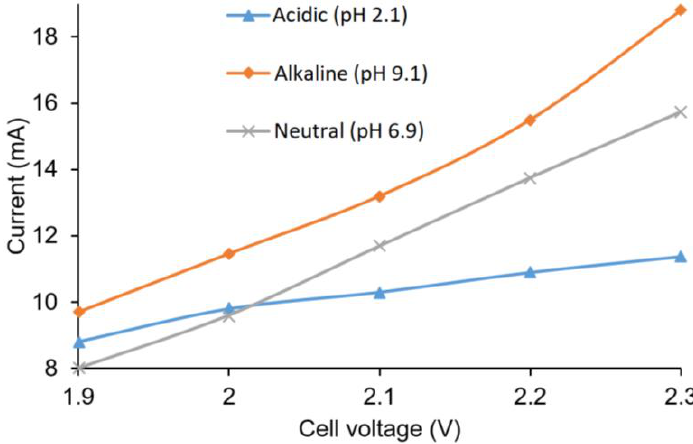
Figure 5. Cell voltage and current output in the buffer solutions.